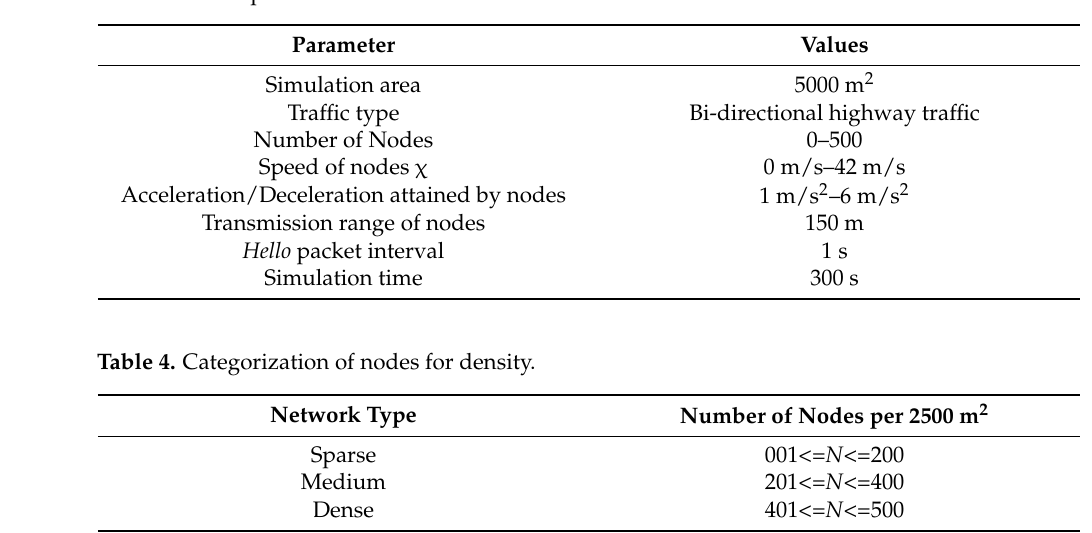
Table 3. List of parameters.